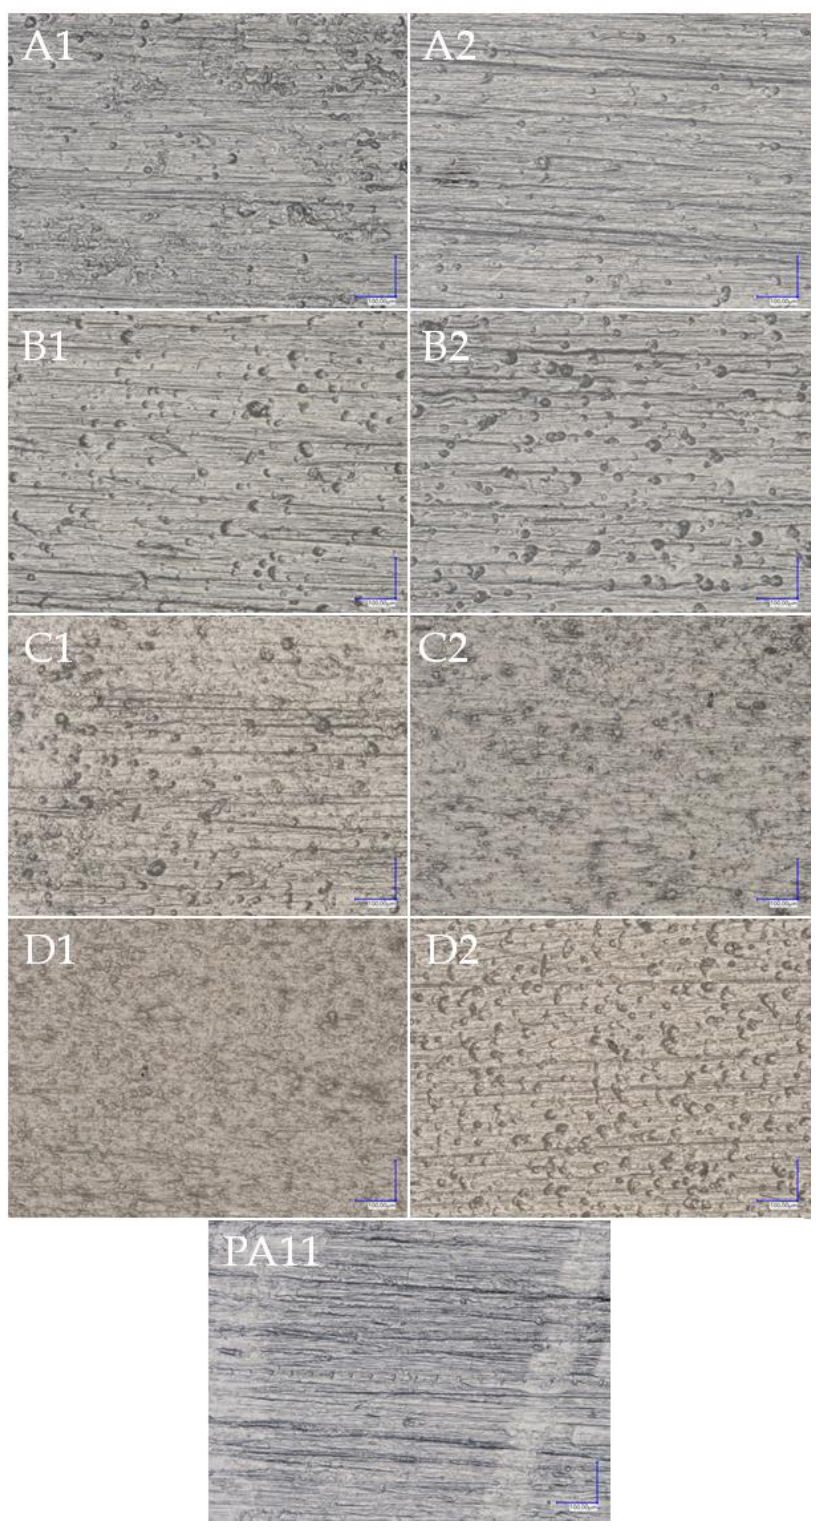
Figure 19. Surface of the composites; ( A1 )—2.5OBS, ( A2 )—2.5OFS, ( B1 )—5OBS, ( B2 )—5OFS, ( C1 )— 10OBS, ( C2 )—10OFS, ( D1 )—20OBS, ( D2 )—20OFS, PA11—Polyamide 11.